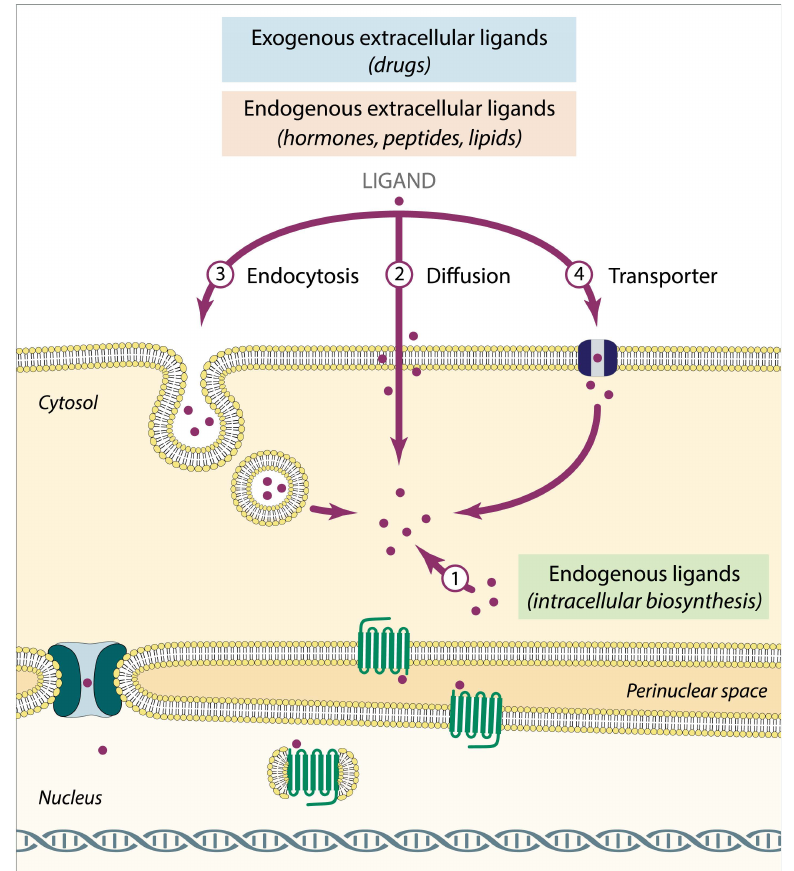
Figure 1. Activation of nuclear G-protein-coupled receptors (GPCRs). Exogenous and endogenous (extracellular and intracellularly produced): (1) biosynthesis of endogenous ligands inside the cell; (2) diffusion of extracellular ligands; (3) endocytosis of extracellular ligands; (4) active transport of extracellular ligands (transporters and